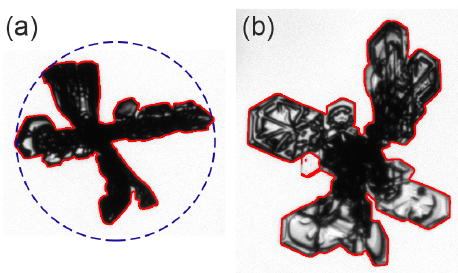
Figure 5. Detected edges of processed ice particle images. The edges are shown in red and have been enlarged to a thickness of 3 pixels for better visibility in this figure. One example, panel (a) shows the edge of the ice particle from Fig. 4. The smallest cir- cle enclosing the particle is shown with a dashed line; its diameter, i.e. the maximum dimension of the ice particle, is 1.34mm (or 358 pixels). The other example in panel (b) shows an ice particle that has been detected with fragmented edge due to parts of the actual particle edge being too bright (see text for more details).